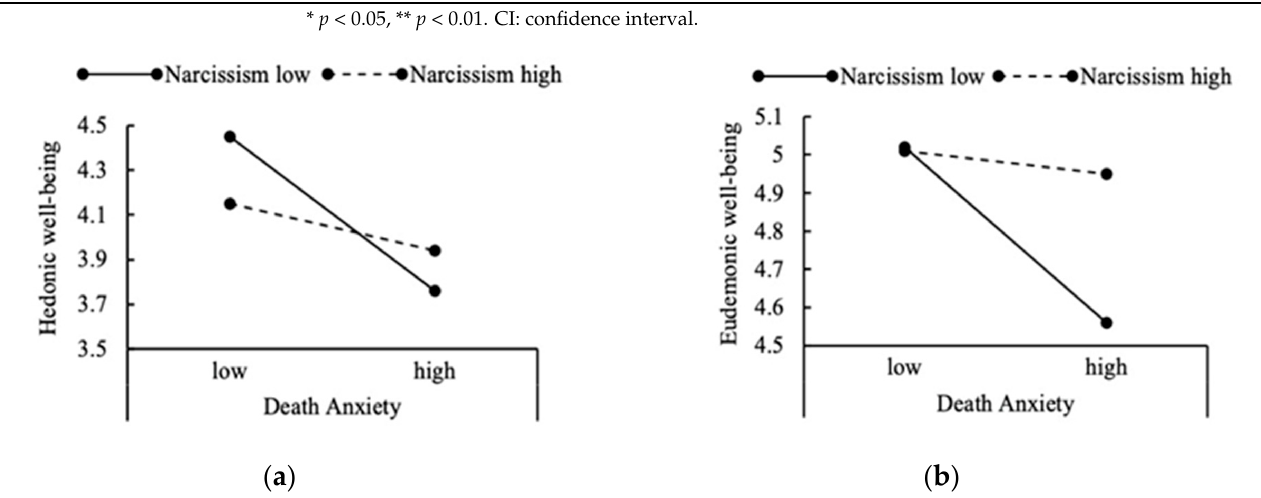
Figure 2. The Simple Slope Analysis, for Individuals ±1 SD From the Mean of Well-being on Nar- cissism: ( a ) the Interaction Effect on Death Anxiety and Hedonic Well-being. ( b ) the Interaction Effect on Death Anxiety and Eudaimonic Well-being.